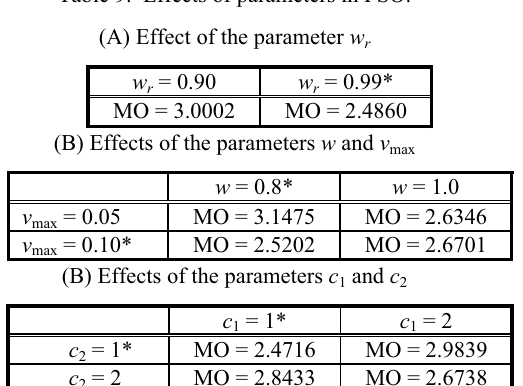
Table 9. Effects of parameters in PSO.